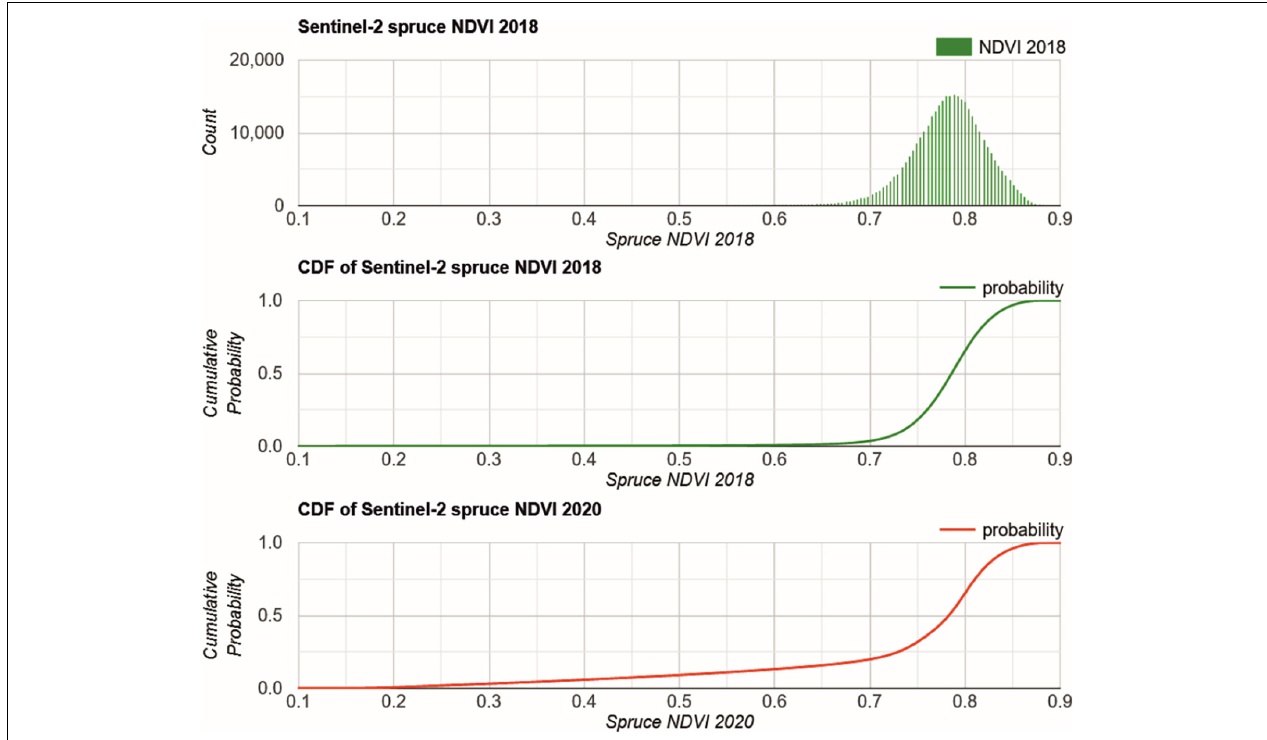
FIGURE 6 | GEE histogram (top) and CDF (center) of spruce NDVI 2018 and CDF (bottom) of spruce 2020. The CDF 2018 is used to identify the NDVI threshold for damaged and warning level spruce according to the forest statistics.